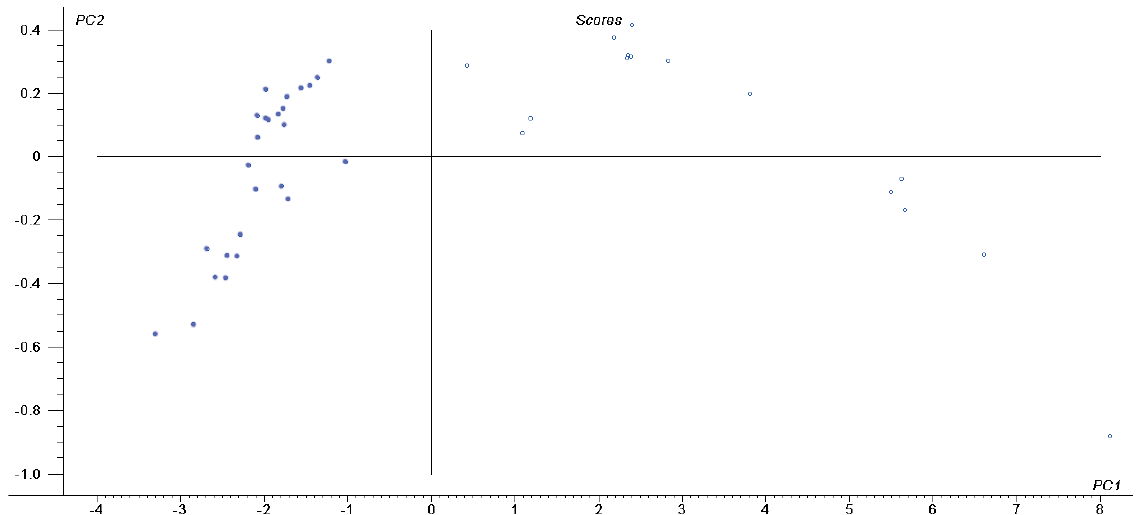
Fig. 3. PCA score of the injection sample UV spectrum (solid circle, Danshen injection; hollow circle, Guanxinning injection).